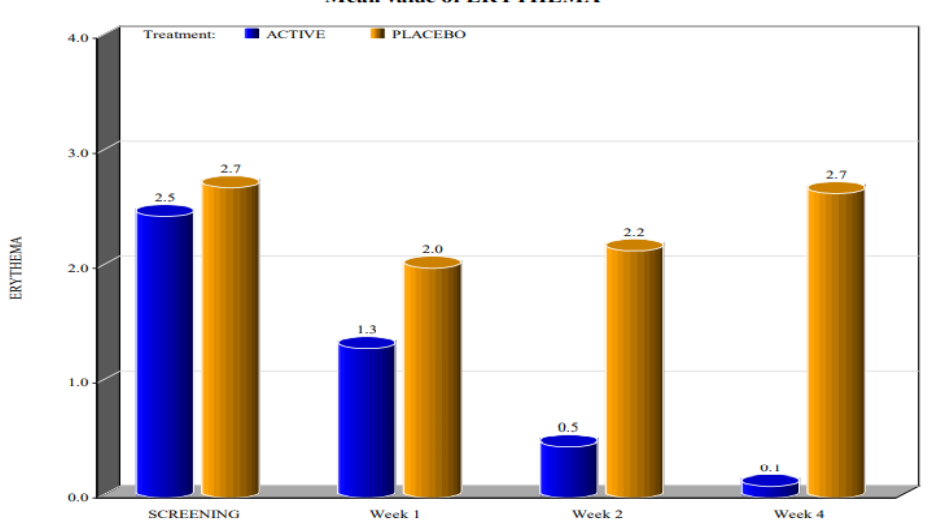
Figure 5. Mean value of erythema ( p value < 0.0001).